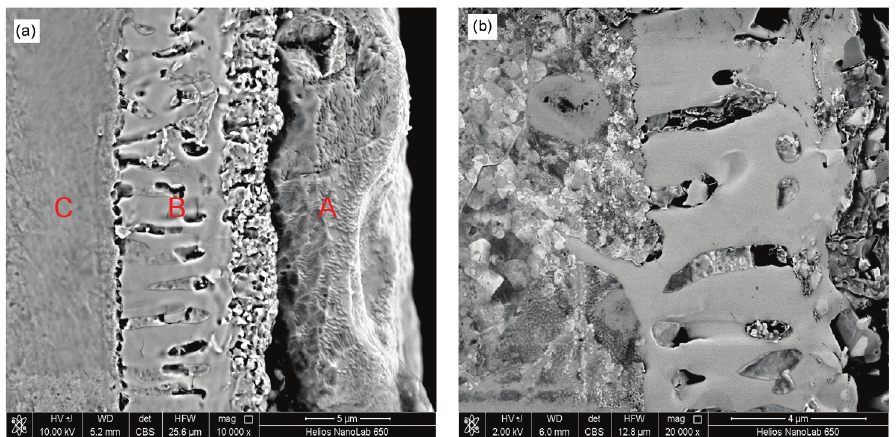
Figure 2: The SEM microstructure of a sample section with the aluminide coating produced in the CVD process; A – outer zone, B – interior zone ( T ¼ 1,050 °C, t ¼ 8 h, p ¼ 150 hPa), C – substrate